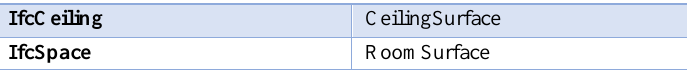
Table 1 . IFC to CityGML Semantic mapping